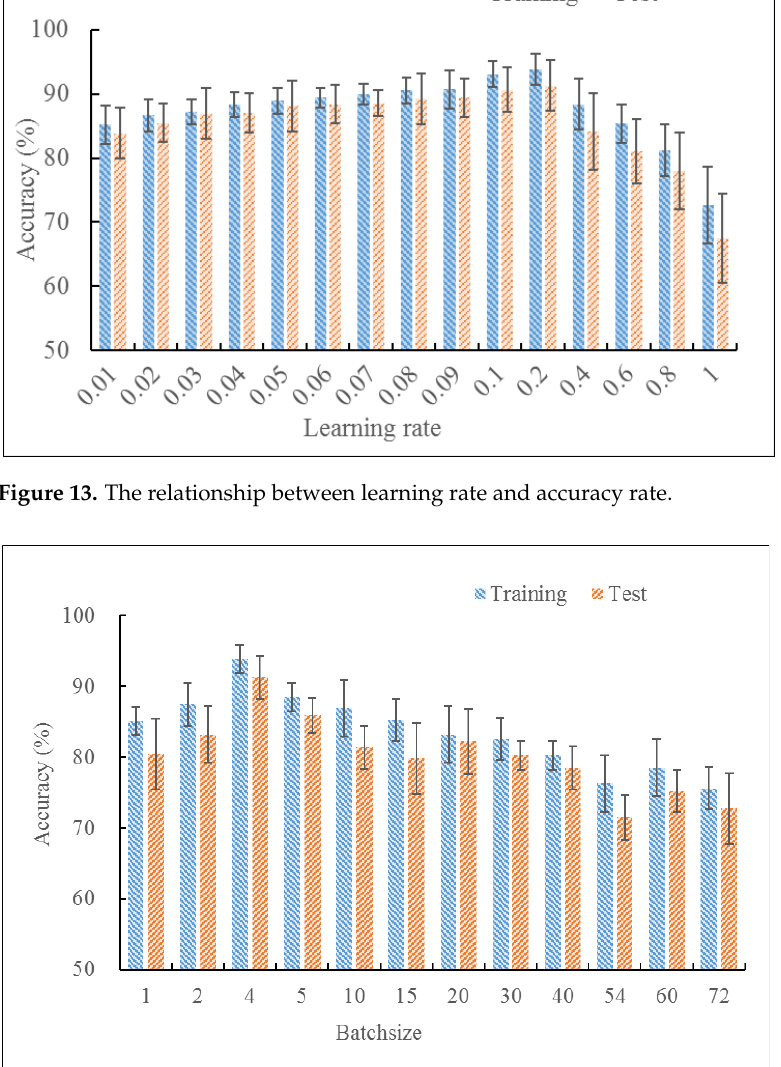
Figure 14. The relationship between batch size and accuracy rate.